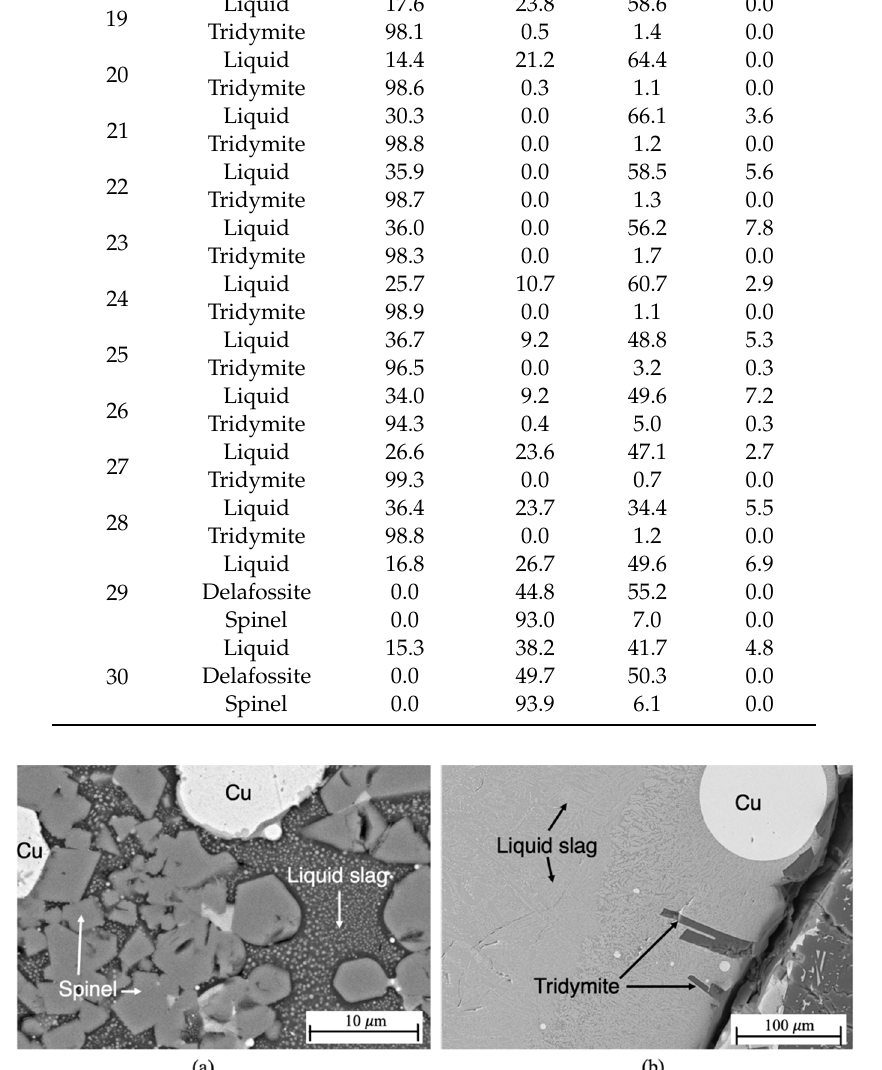
Figure 3. Scanning electron micrographs of quenched liquid slags in equilibrium with spinel ( a ) and tridymite ( b ) and saturated with metallic copper.